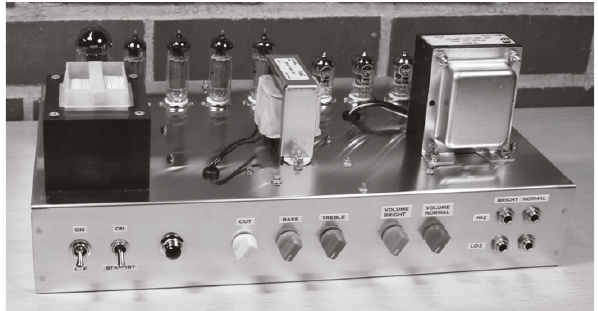
Figure 1: The custom-built AC30 tube guitar amplifier (photo by Ari